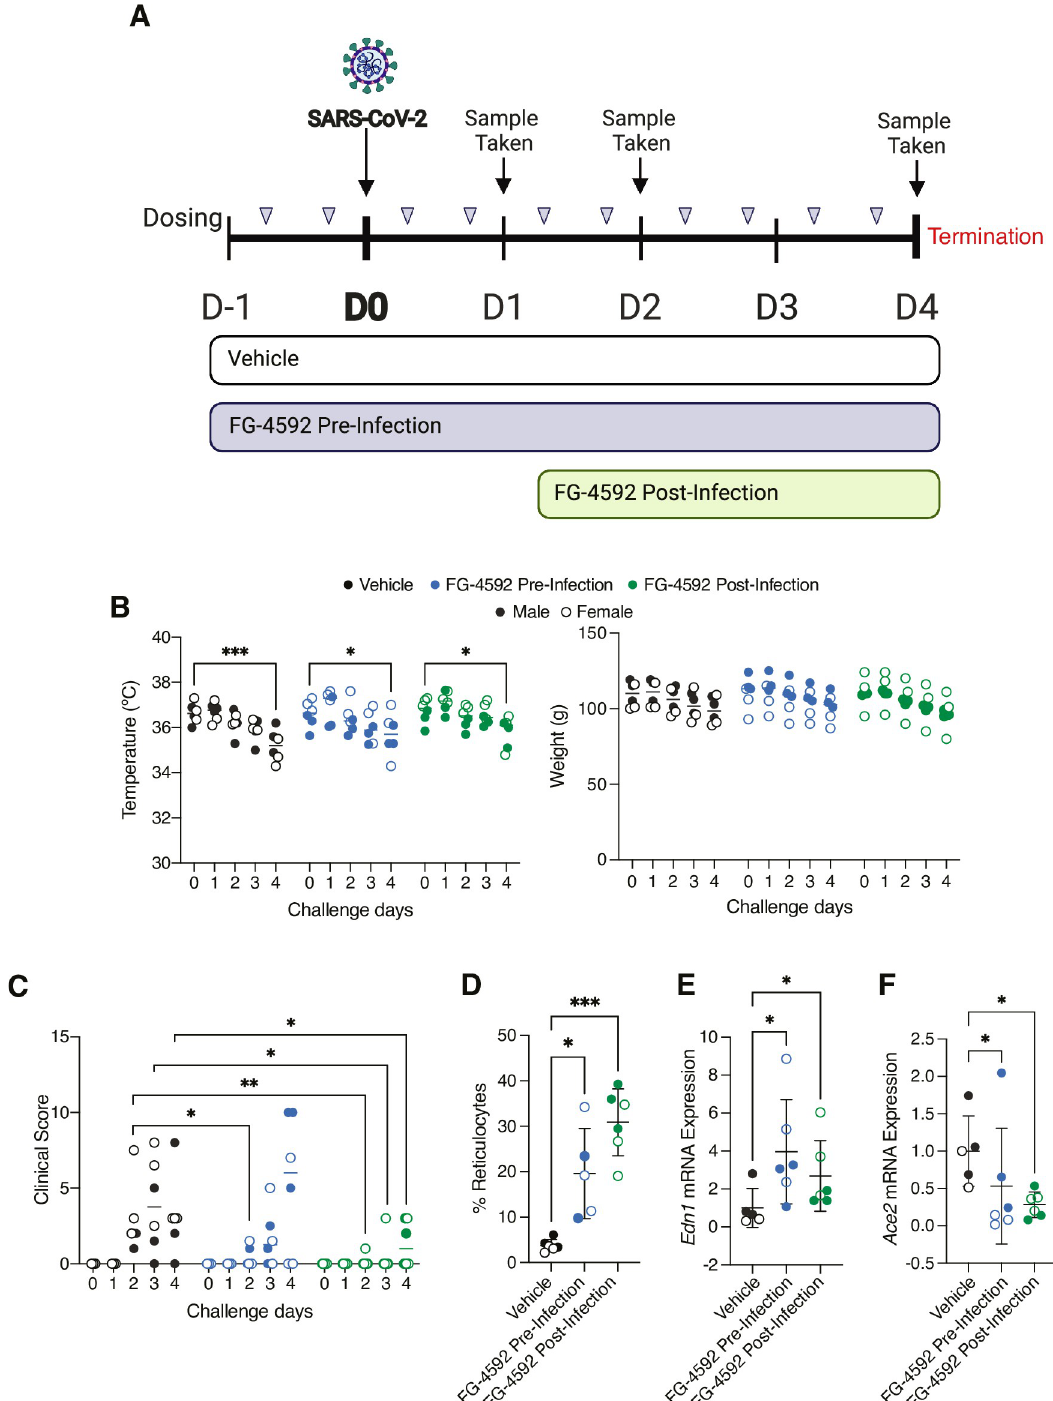
Fig 1. Evaluating FG-4592 in the Syrian hamster model of SARS-CoV-2. (A) Schematic of the challenge study. 18 animals aged 7 weeks were allocated into groups of 6 for each treatment. For vehicle and pre-infection groups, twice daily dosing of vehicle or 30mg/kg of FG-4592 administered by oral gavage commenced 24h prior to intranasal challenge with SARS-CoV-2 VIC01/2020 (5x10 4 PFU). For the post-infection treatment group, FG-4592 dosing started 24h after viral infection. On days 1, 2 and 4 post- infection, nasal washes and throat swabs were collected for assessment of viral load and infectious titre. The study was terminated at 4 days post-infection. (B) Hamster temperature and weight measurements over the course of the study. Weights were measured daily, and temperature recorded twice daily with average measurements for each animal plotted. (C) Clinical scores from daily